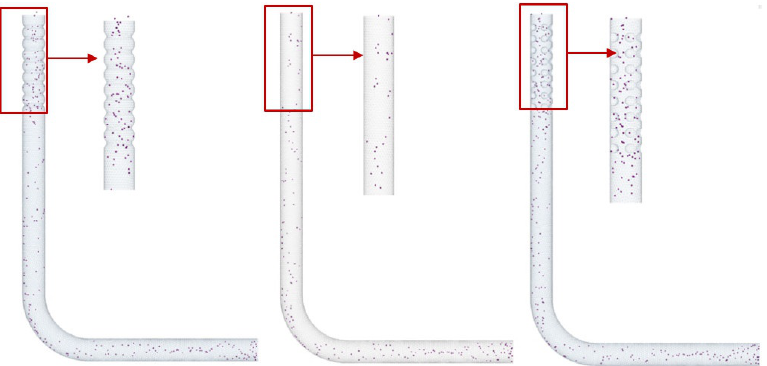
Figure 8. Distribution of rapeseeds in different seed tubes.